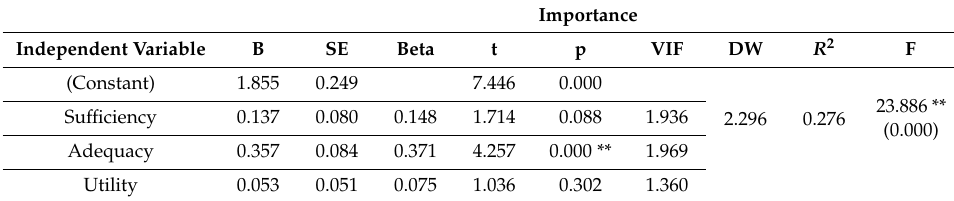
Table 9. E ff ect of content on the importance of the recommendation